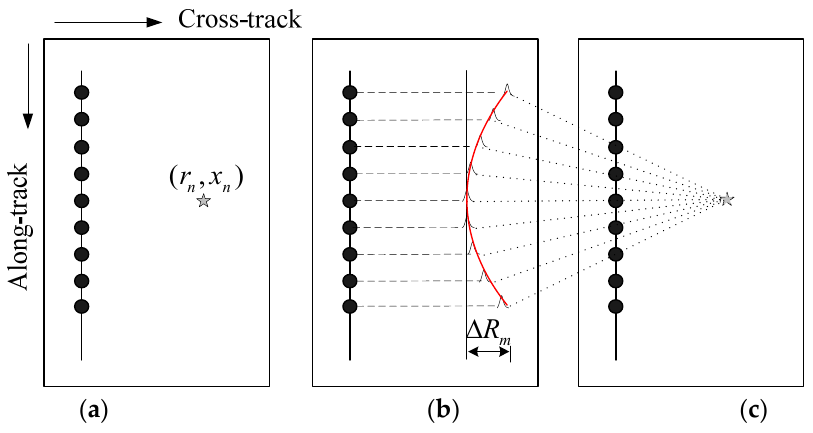
Figure 3. Multi ‐ receiver SAS imaging geometry. ( a ) Object space; ( b ) data space; ( c ) image space. In Equation (4), f τ is the instantaneous frequency in the cross-track dimension. Ss i ( f τ , t ) is the spectrum after performing FFT in the cross-track dimension with respect to (3). P ( f τ ) is the spectrum of the transmitted signal. conj {·} denotes the conjugation of transmitted signal. Ss ci ( f τ , t ) stands for the compressed